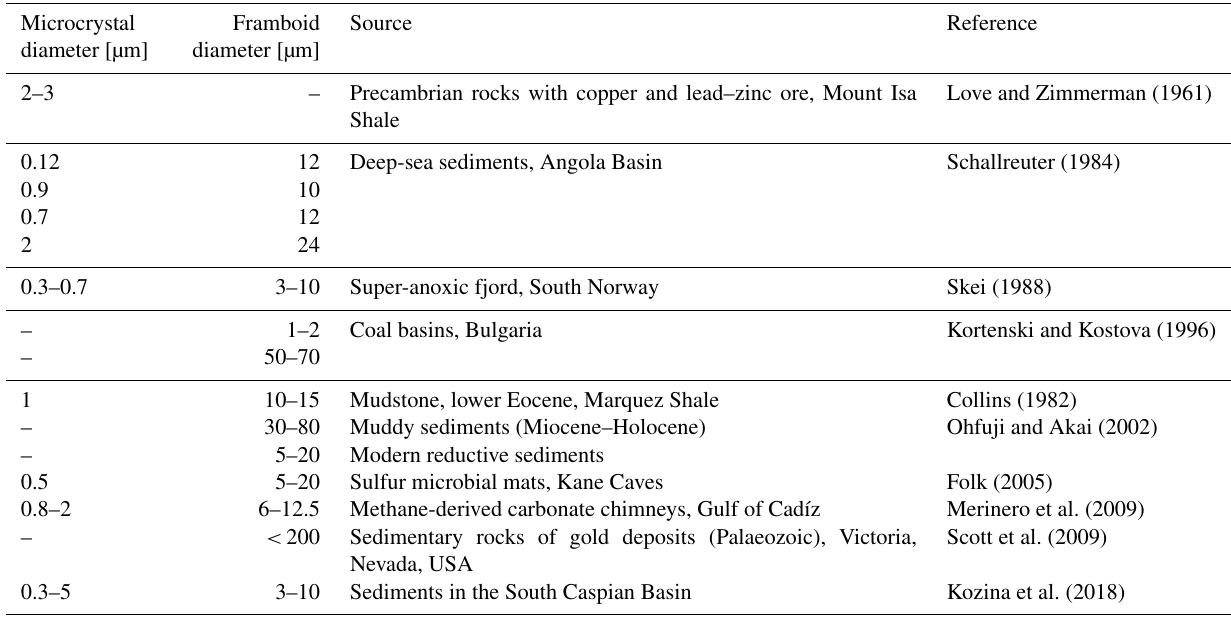
Table 1. Sizes of framboid diameter and their microcrystals.